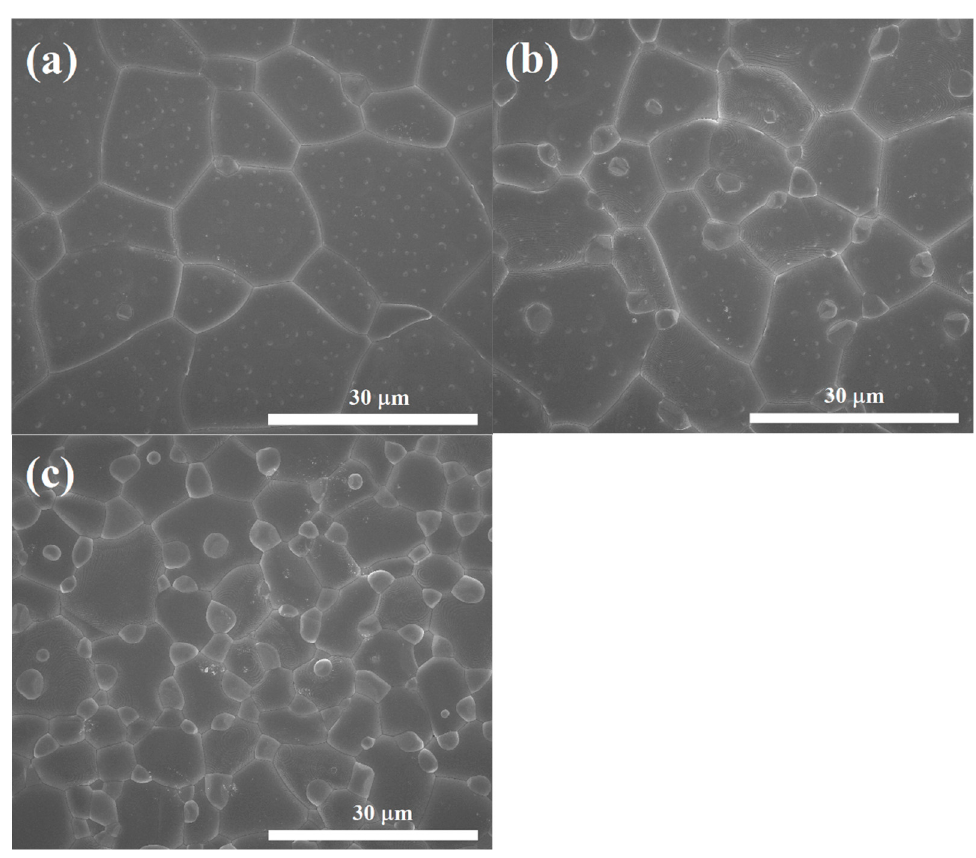
Figure 2. Surface morphologies of ( a ) LuNTO ‐ 1, ( b ) LuNTO ‐ 2, and ( c ) LuNTO ‐ 3 ceramics.